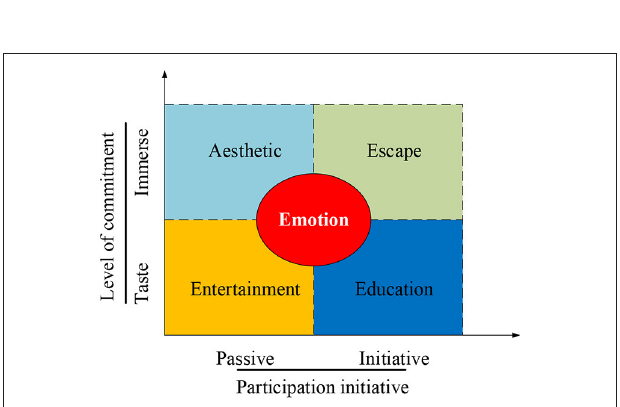
FIGURE 3 | “4E” model based on tourism